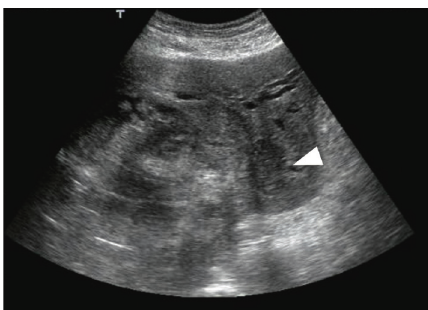
Figure 3: Abdominal ultrasonography showing a 15-mm hypoechoic mass in liver segment S2 adjacent to the bleeding (arrowhead). A percutaneous biopsy was performed.